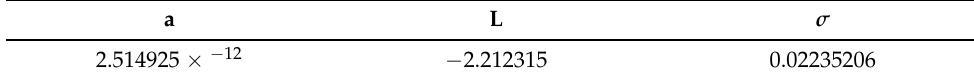
Table 2. Estimation result of IGBM for fuel-switching data.